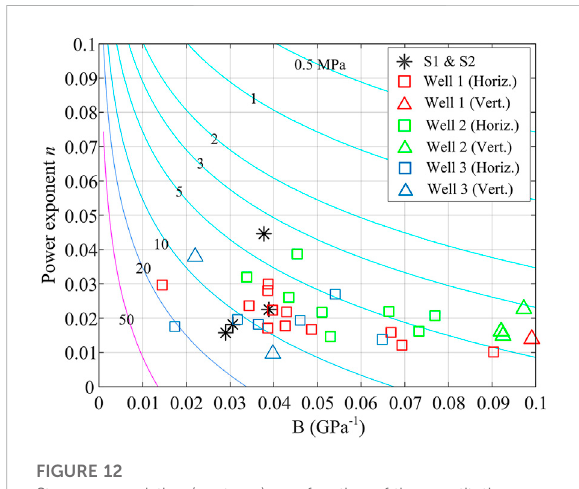
FIGURE 11 Stressrelaxationfactorasafunctionofthepowerexponent n forseveraltimescalesfromseveraldaysupto200millionsofyears (Myr). For comparison, the constitutive parameters of all the samples are plotted.